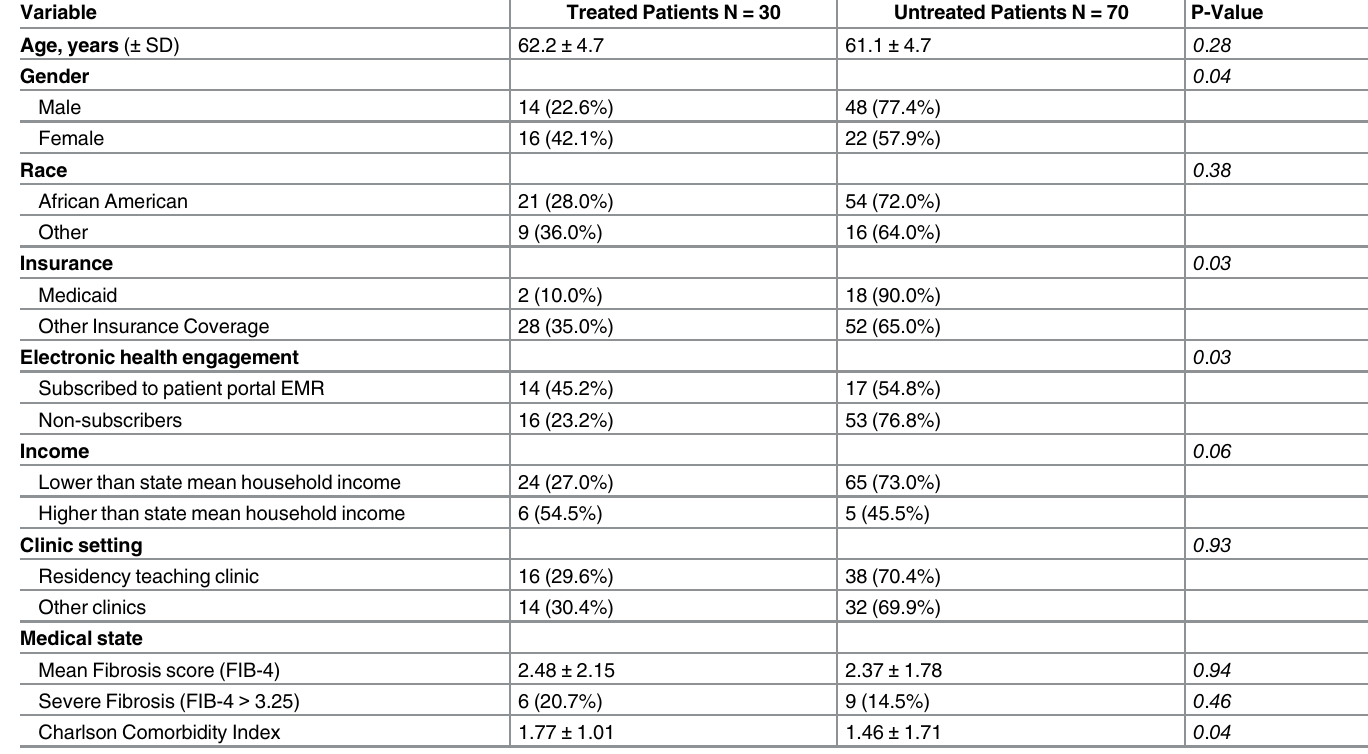
Table 4. Univariate analysis comparing hepatitis C virus positive patients who received treatment to untreated subjects.